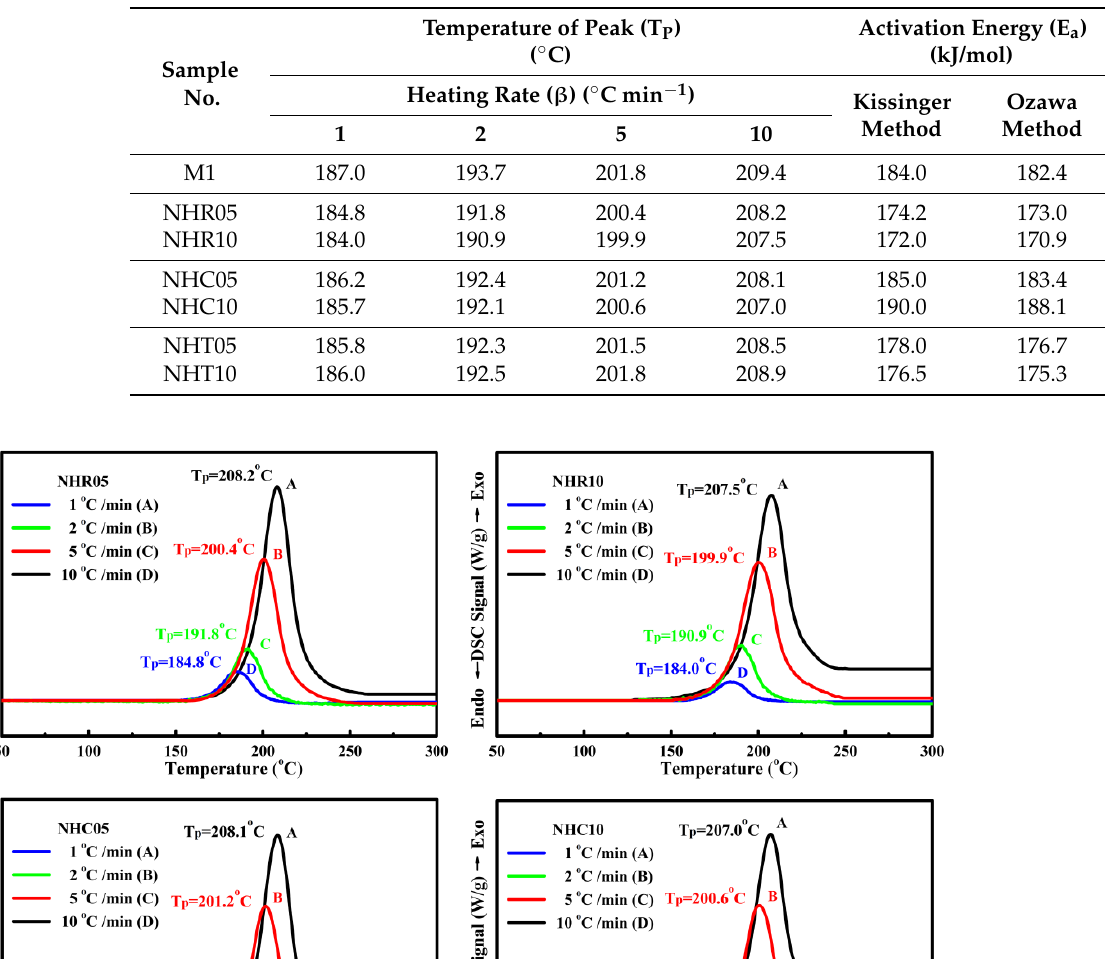
Table 2. Activation energy values of decomposition reactions of test samples calculated by the Kissinger and Ozawa methods.